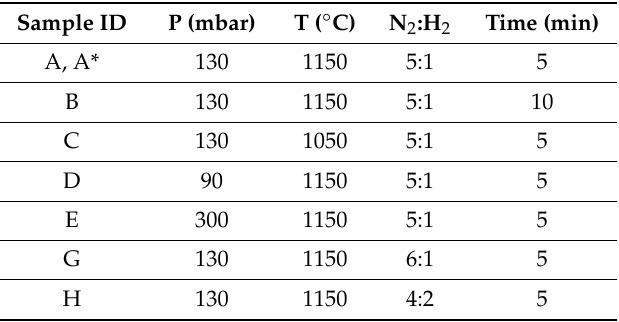
Table 1. In-situ etching parameters for the GaN layers; pressure (P), temperature (T), etching gas flow (N 2 : H 2 ) and time of etching in MOVPE for each sample.